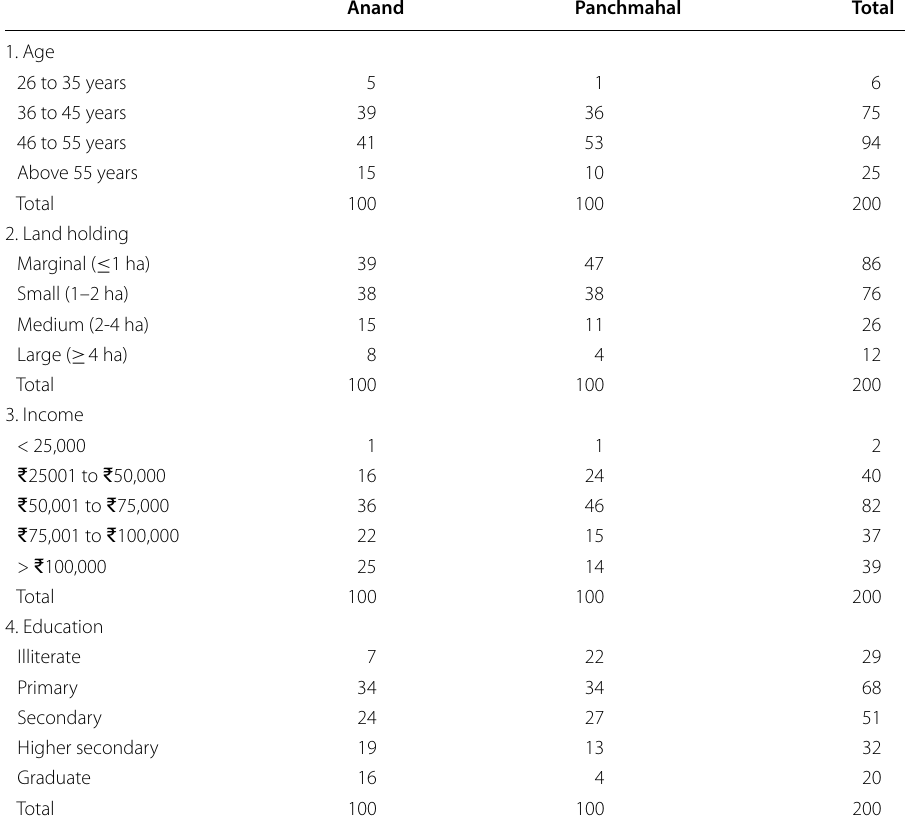
Table 2 Socio-economic profile of the sample respondents (Farmers only). Source: Primary survey of sample